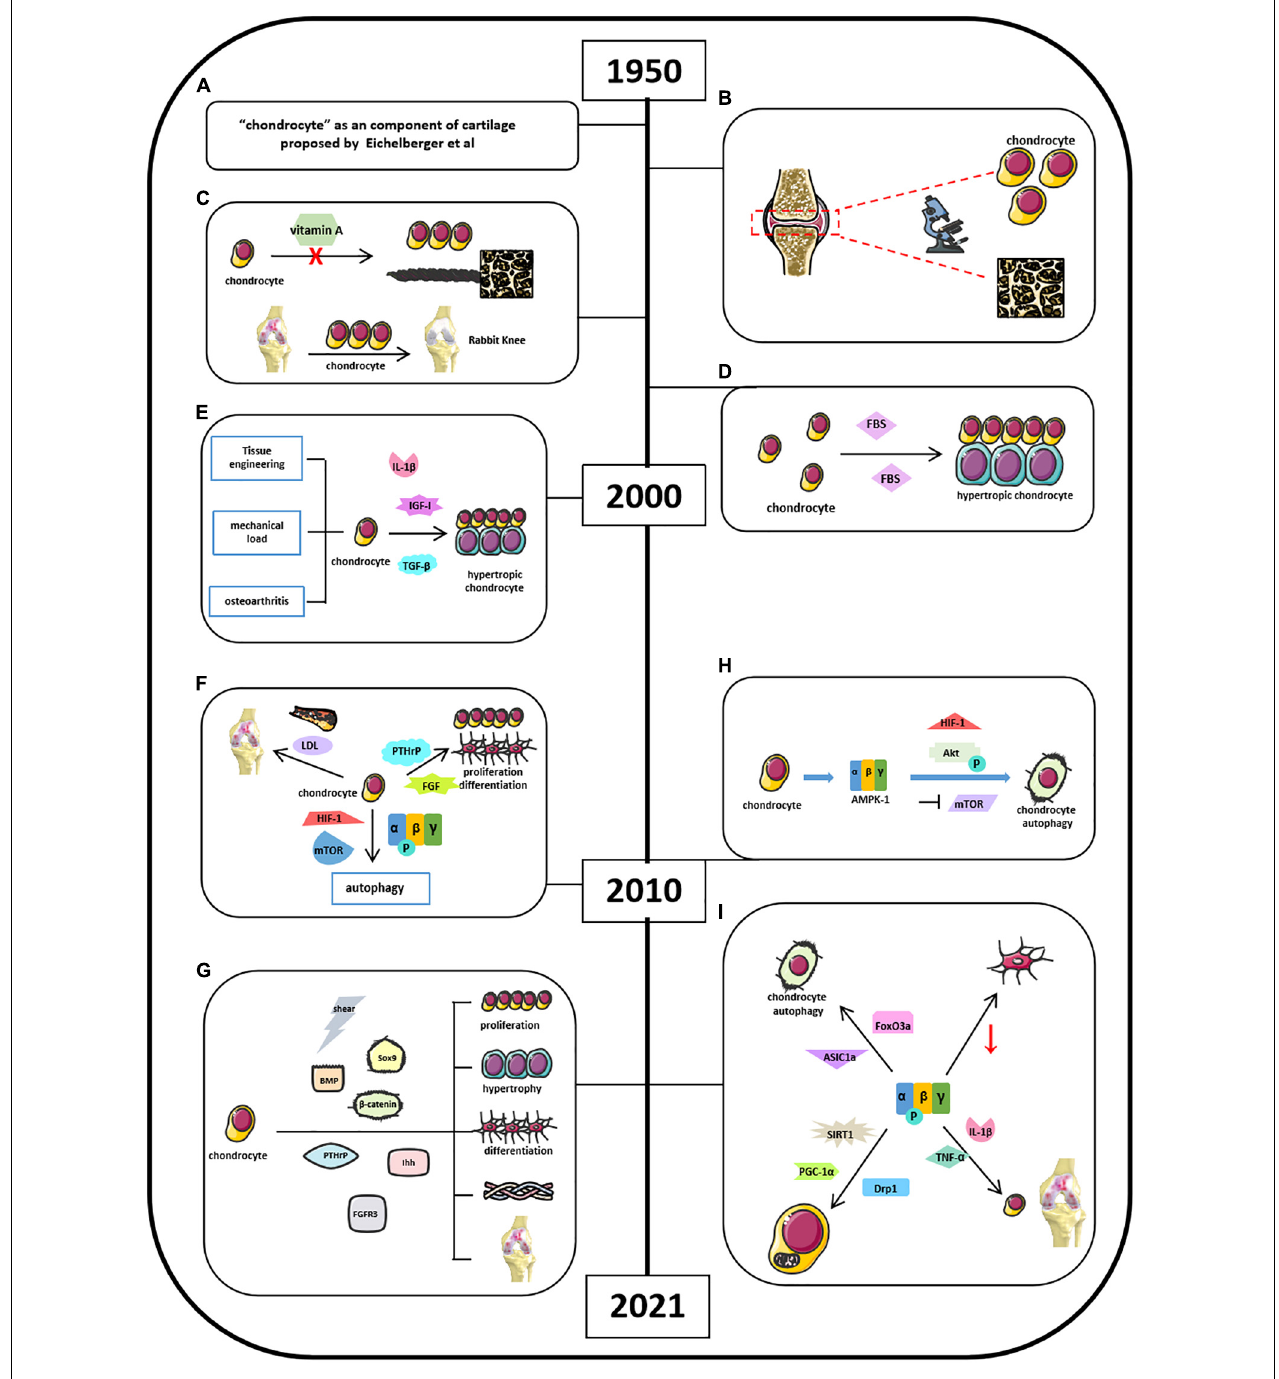
FIGURE 3 | Milestones of discoveries of chondrocytes and the role of AMPK in cartilage chondrocytes. (A) Eichelberger et al. (1951) proposed “chondrocyte” as a component of cartilage. (B) Godman and Porter applied electron microscope to reveal the evolution of chondrogenesis. (C) Vitamin A could inhibit chondrogenesis and limiting extracellular space. (D) Cell density and FBS concentrations determine the transitional fate of resting chondrocytes to proliferative and hypertrophic chondrocyte. (E) Understanding of chondrocytes associated with osteoarthritis and upstream mediators in regulating chondrocyte activities. (F) Factors involved in cartilage chondrocytes’ homeostasis by 2010. (G) Current signaling pathways mediate chondrocyte activities. (H) Mouse chondrocytes expressed energy sensor AMPK-1, which promotes chondrocyte autophagy associated with Akt activation, mTOR suppression, and HIF-1 expression. (I) Current AMPK-related signaling pathways in mediating chondrocyte